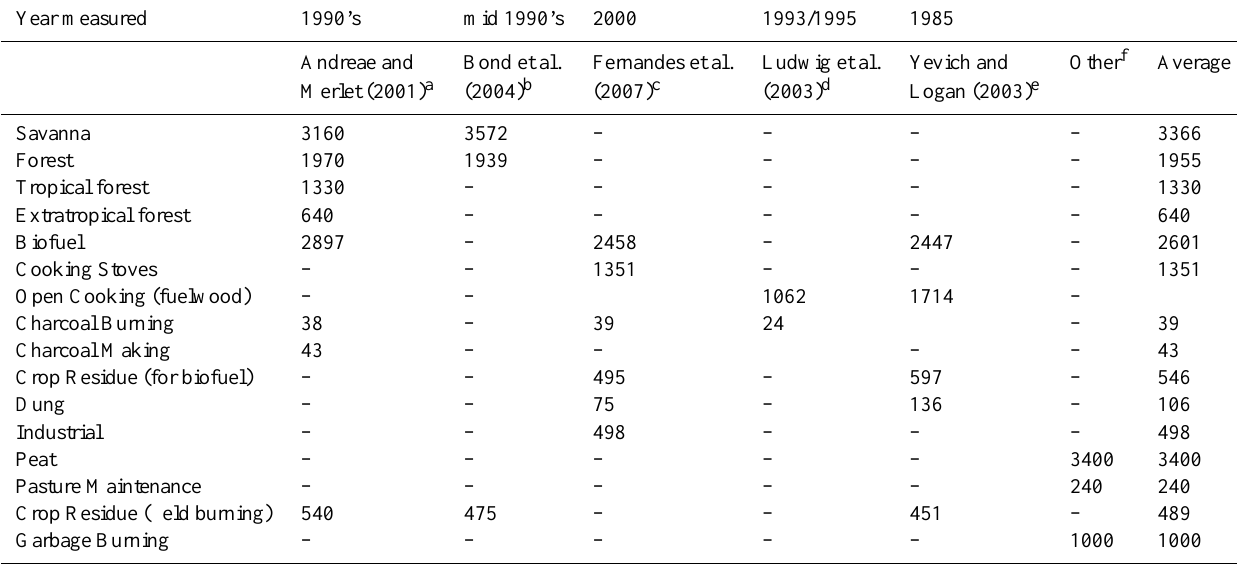
Table 4. Global estimates of biomass consumption in units of mass of dry matter burned (Tg) per